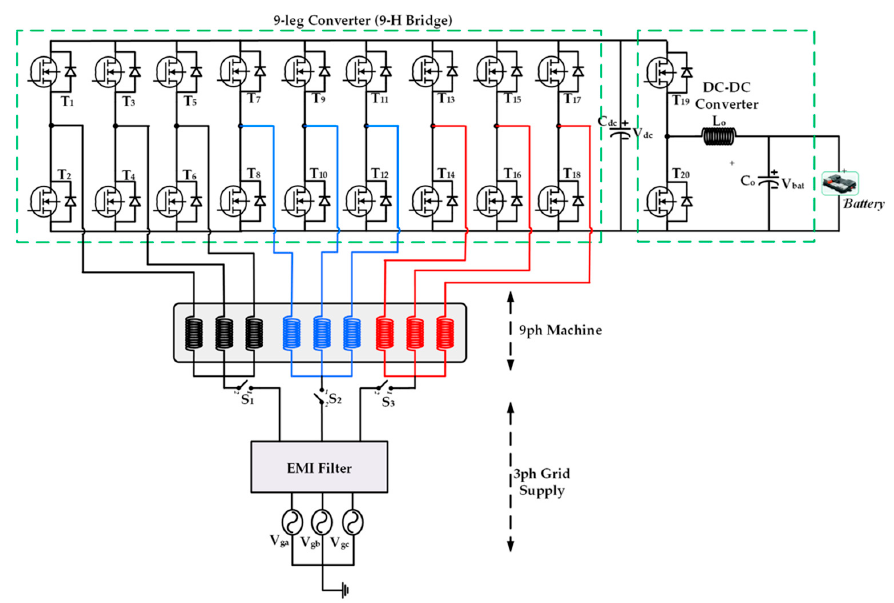
Figure 16. Integrated On − Board Charger based on Nine Phase Winding Machine proposed by Abdel-Khalik et al. [84] in 2017 (iOBC12).